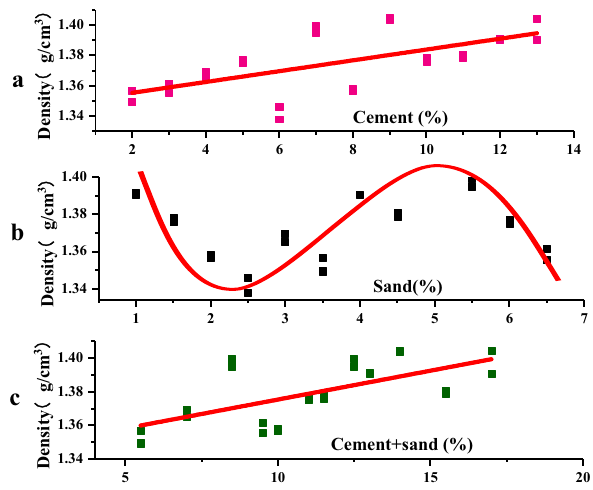
Fig. 5 Density relationship between cement, sand and coal-like material strength of similar material specimen. Figure 7b shows the